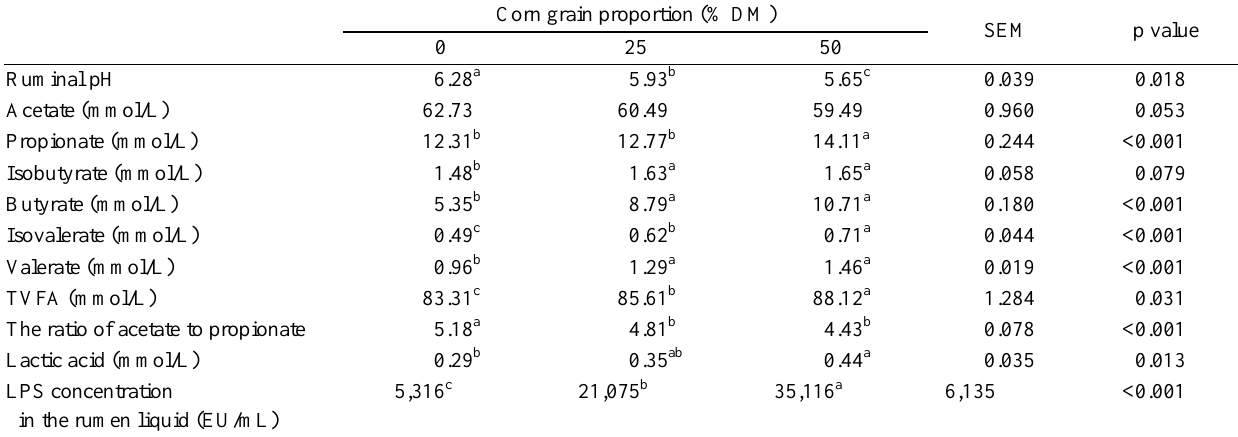
Table 2. Rumen pH, rumen fluid composition and LPS concentration